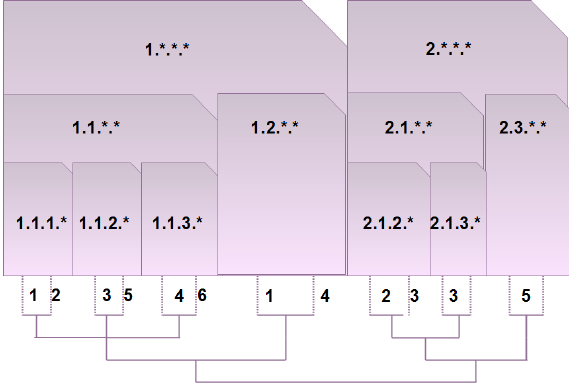
Figure 4: Unequal scaling based on the ratio of each classified